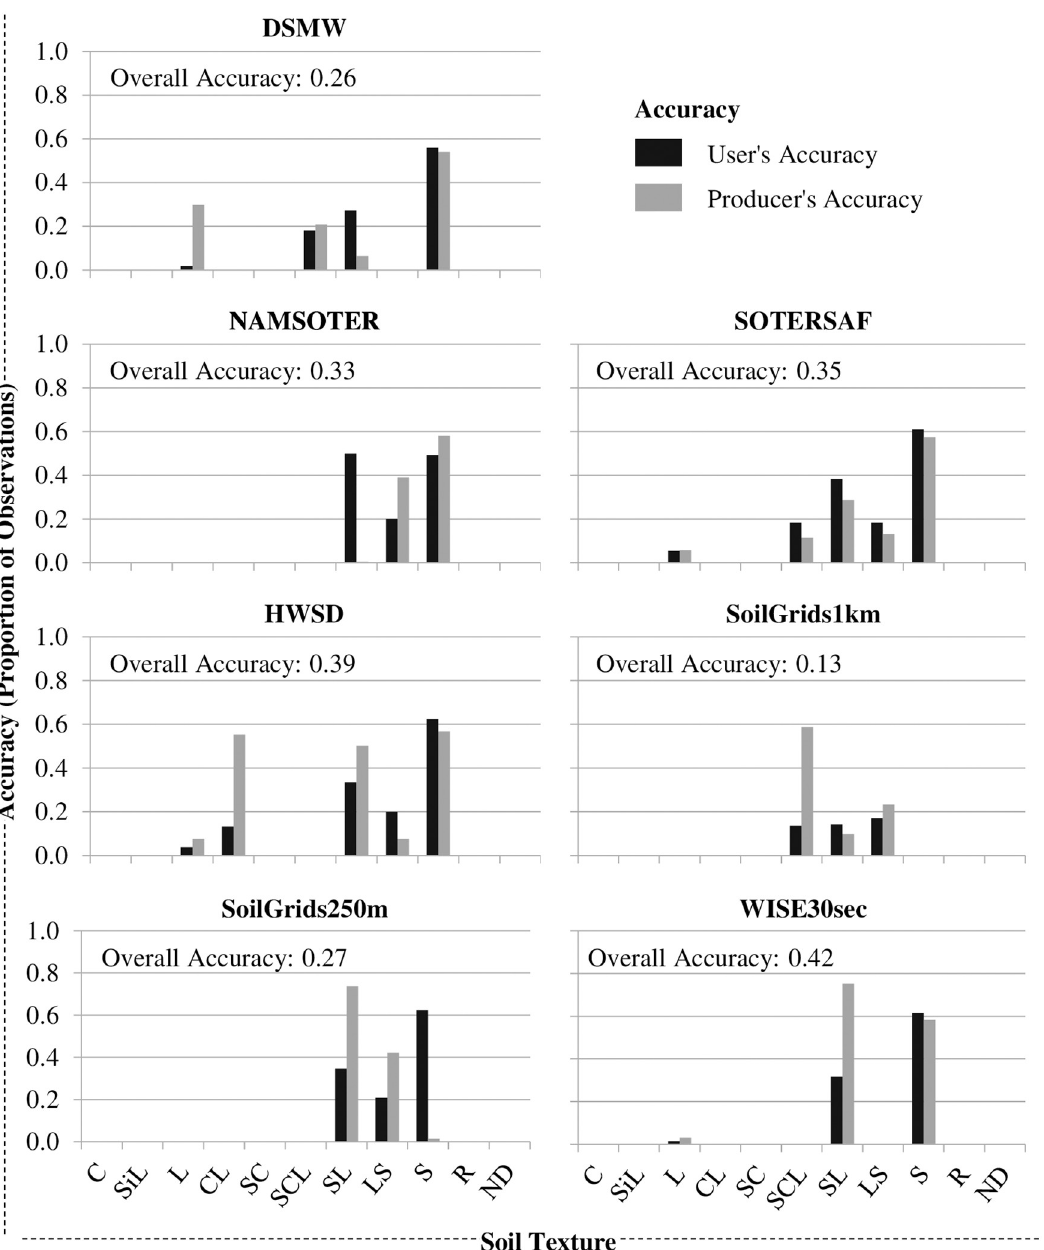
Fig 8. User’s and producer’s accuracies of the different topsoil texture categories in the maps and overall map accuracies. See the section on “Topsoil Texture Map Accuracy Assessment” for definitions of user’s and producer’s accuracies. SiC, SiCL, and Si are not shown because these were not represented in any of the field samples or maps. See the text for full names and versions of the map data sources.